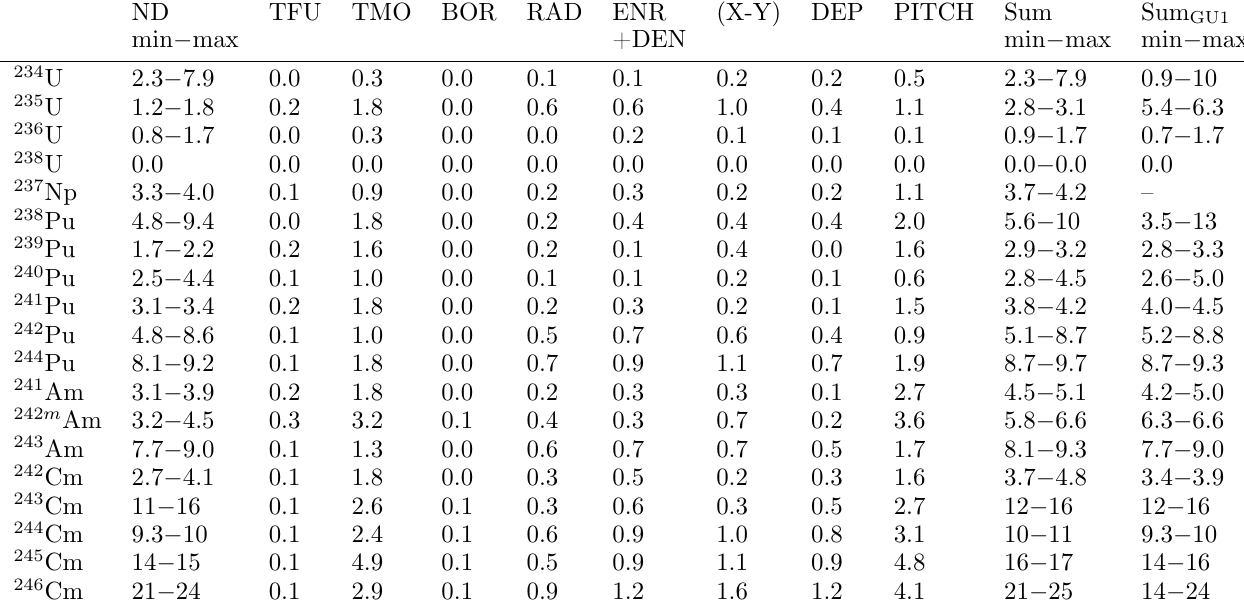
Table B.4. Summary of all uncertainties in% (or 1 σ ) for the GU3’ sample considered in this study for actinides. For nuclear data (ND), the range from Tables B.2 and B.3 is presented here. The “Sum” column corresponds to (cid:112)(cid:80) ∆ 2 ( C i ) for calculated uncertainties. The sum for the GU1 sample is also indicated (without the systematic effect i of 2% for the mass balance). See text for the description of the